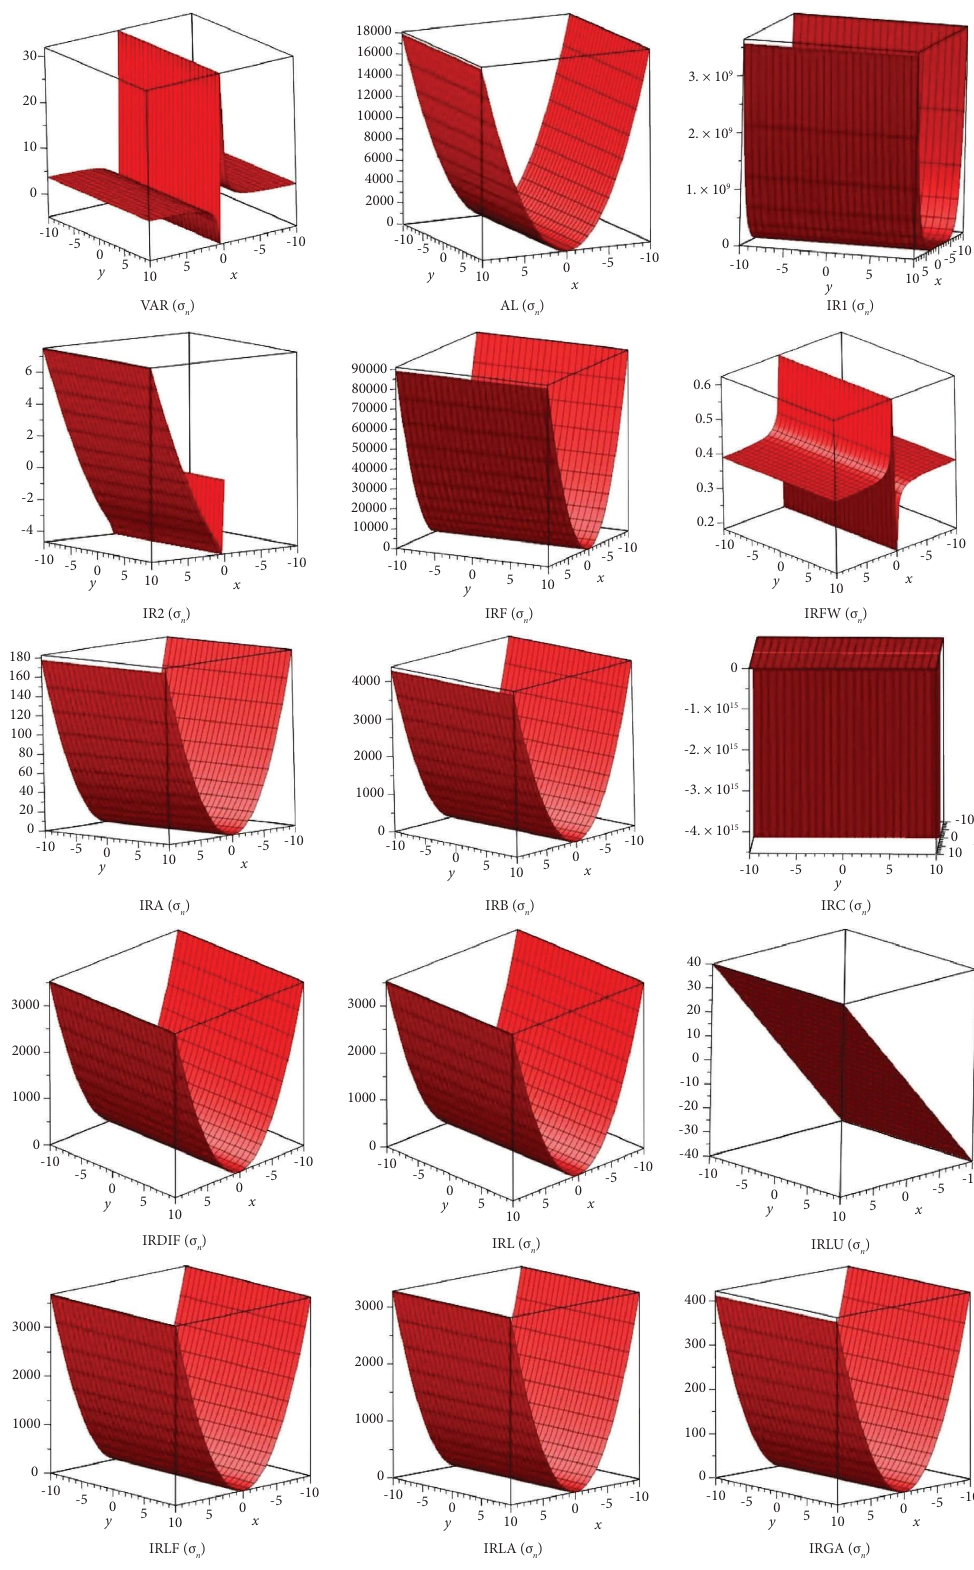
Figure 5: 3D plot for irregularity indices for σ